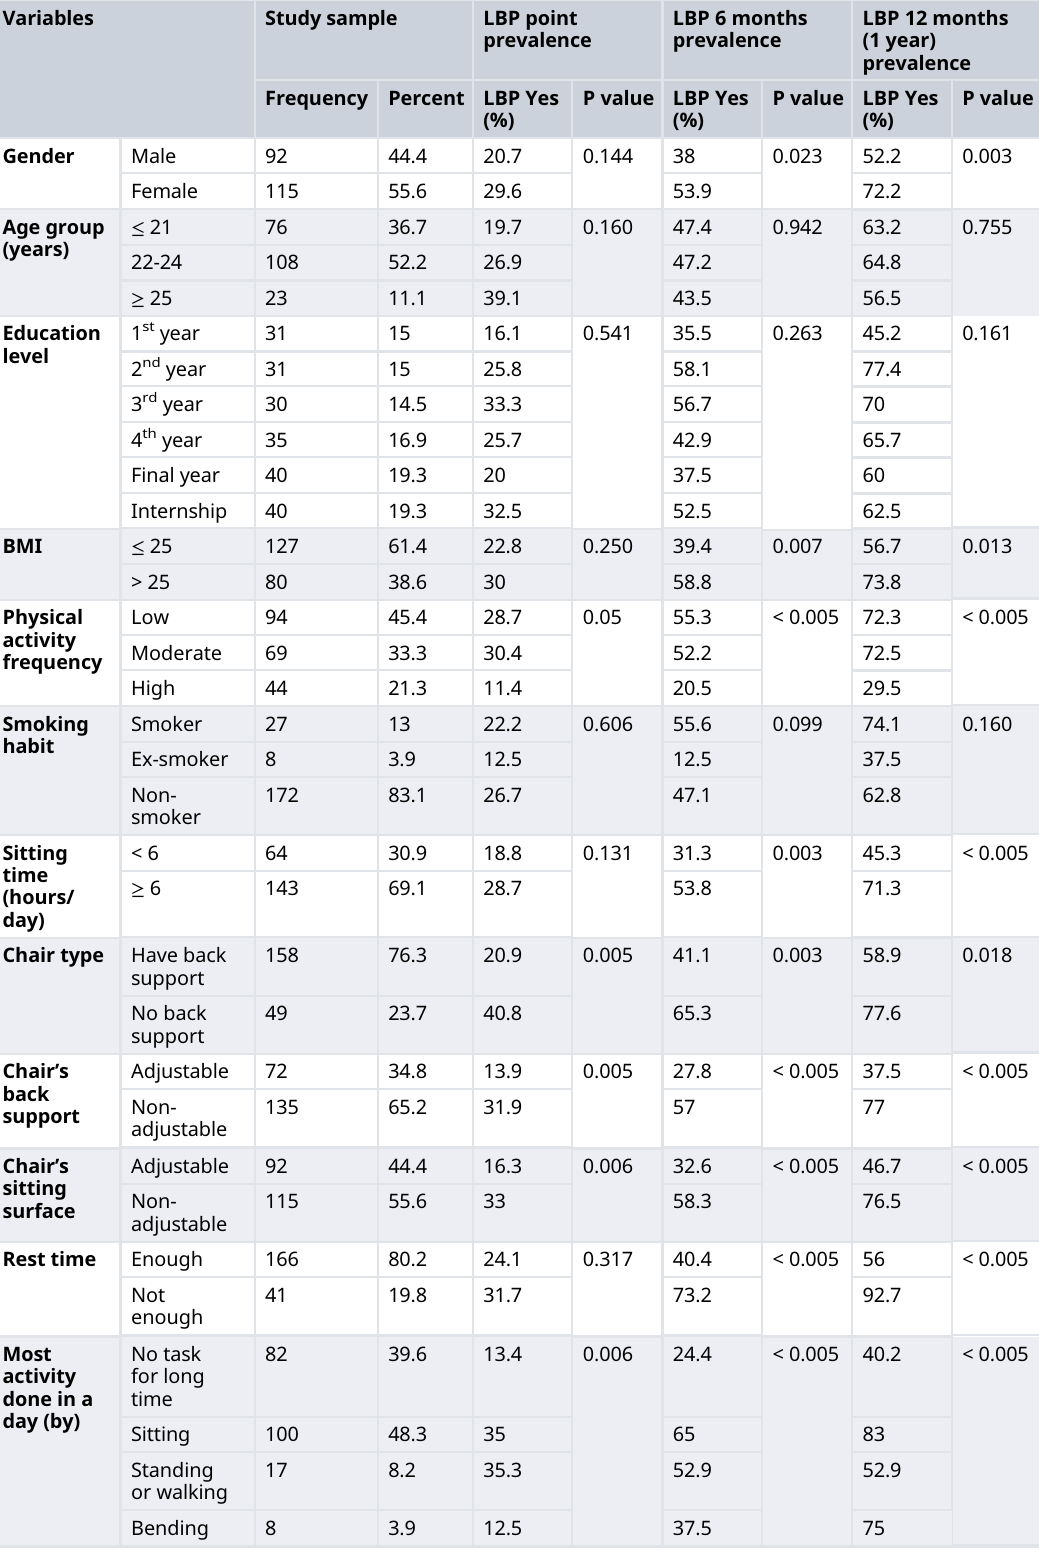
Table 1. Socio-demographic and lifestyle-related factors associated with LBP and LBP prevalence (n = 207).